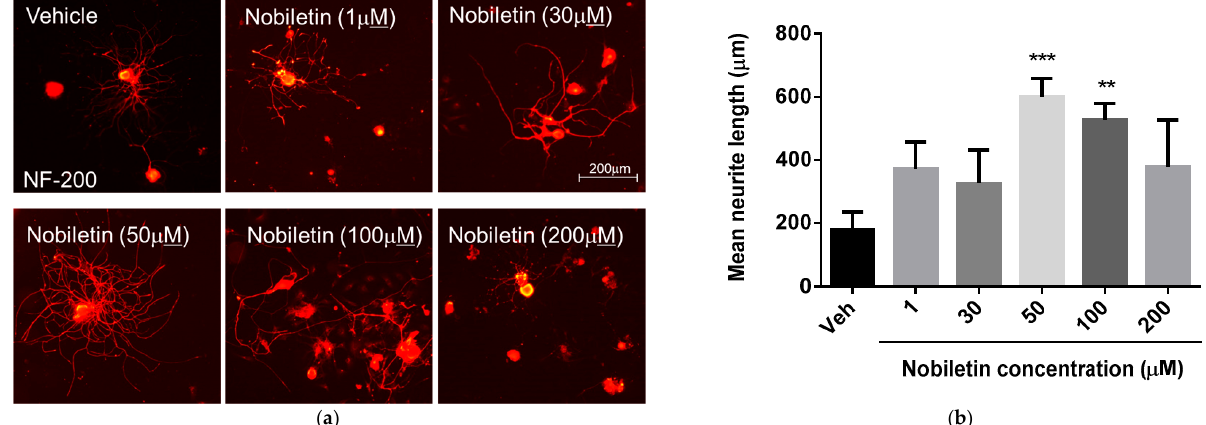
Figure 2. Nobiletin enhanced neurite outgrowth of primary cultured DRG neurons. For the effect of nobiletin on neuronal cell morphology, L4-5 DRG neurons were dissociated 3 days after SNI and plated on 60 mm culture dish. Twelve hours later nobiletin was treated in a concentration–dependent manner. Following 36 h, cultured DRG neurons were stained with anti-NF-200 antibody. ( a ) Representative images of neurite outgrowth of DRG sensory neurons after exposure to different concentration of nobiletin in the culture dishes. ( b ) Quantitative graph of DRG neurite length. Nobiletin at a dose of 50 and 100 μ M significantly increased mean neurite length of DRG neurons ( n = 6, this culture repeated three times with two rats each). ** p < 0.01, *** p < 0.001 compared to vehicle treated group; Veh, vehicle group, NF-200, neurofilamen-200.